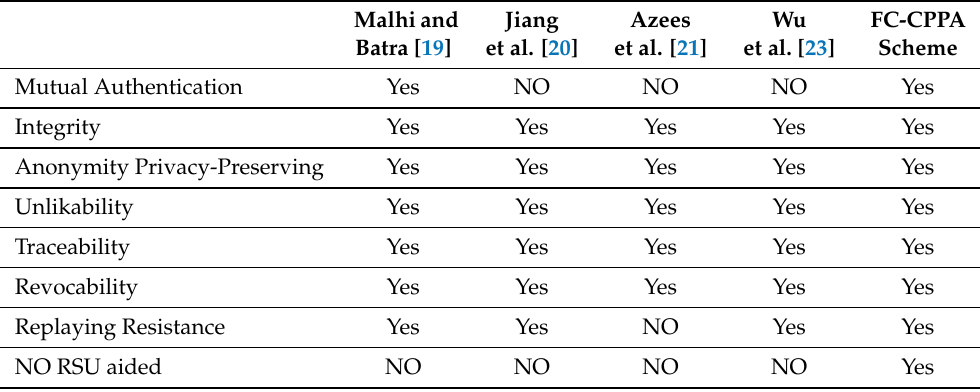
Table 1. Analysis of Current Authentication Systems’ Security.